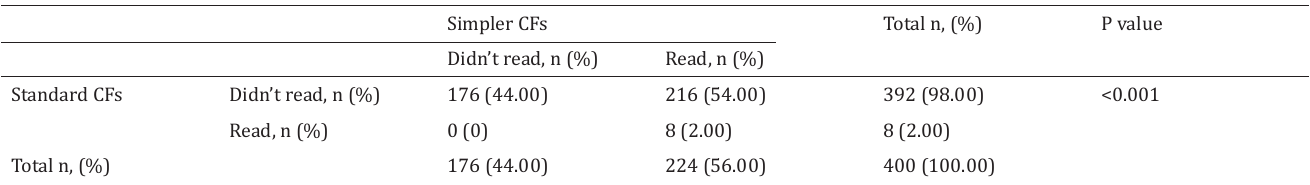
Comparative analysis of the respective CF reading rates among patients receiving IVIT